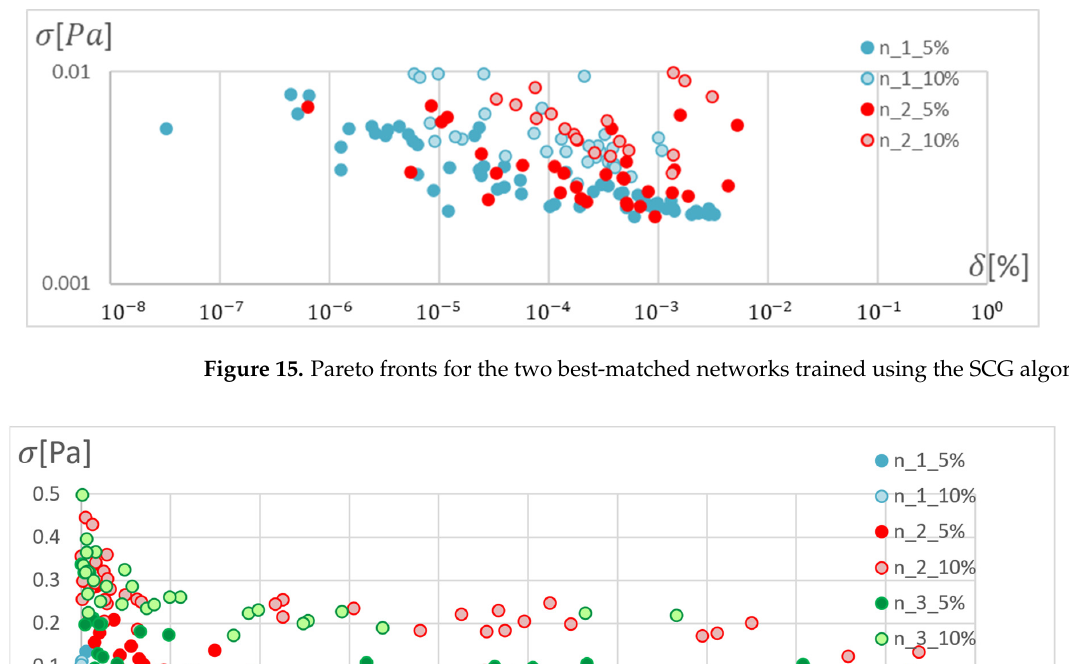
Figure 14. Pareto fronts presented on a logarithmic scale for all networks trained using the SCG algorithm.